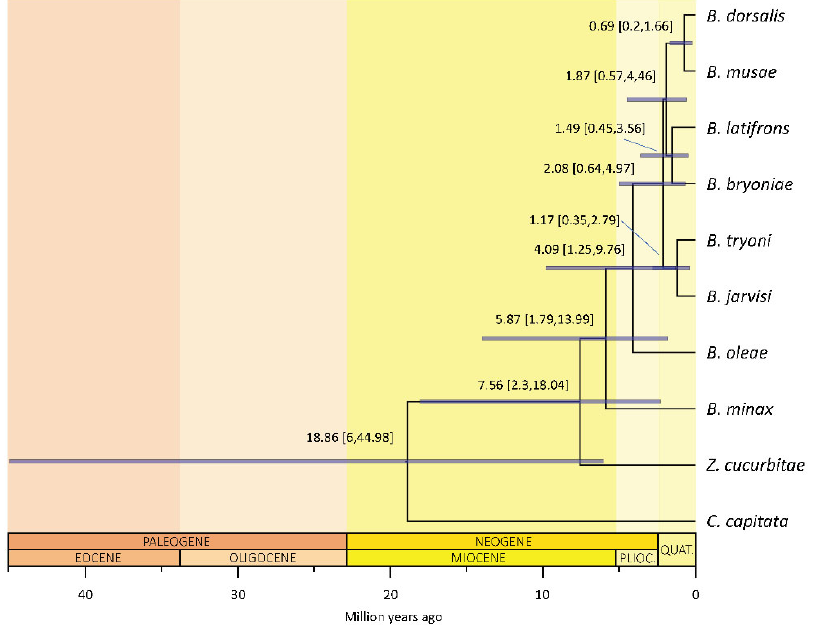
Figure 2. Molecular time tree of Bactrocera . Bactrocera (plus Zeugodacus ) likely originated during the Miocene optimum (around 19 mya) and experienced recent, fast cladogenetic events less than 5 mya. The analysis was conducted setting the mutation rate log-normally distributed as prior, a strict clock and a birth–death model. Mean and 95% highest posterior density of the inferred age (blue bars) are reported for each node.